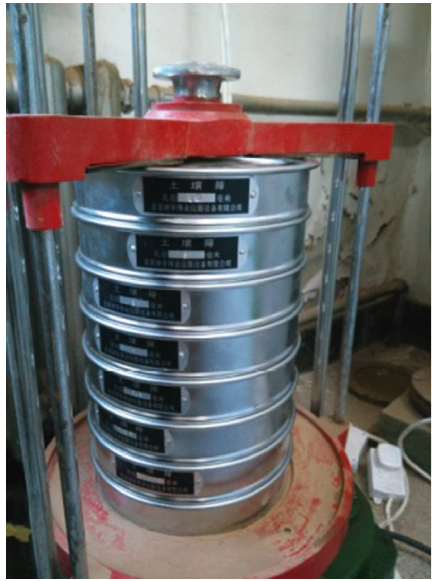
Figure 2: The dry sieving test.